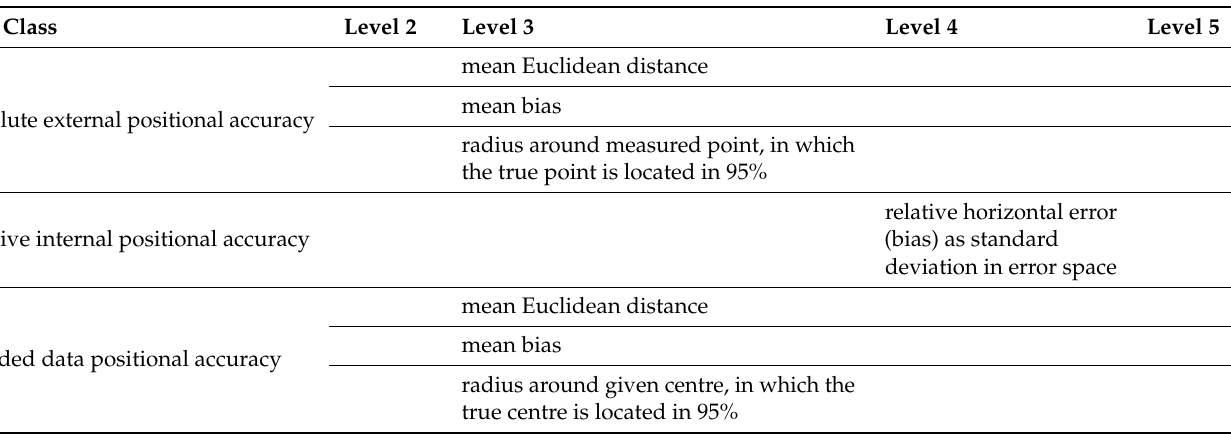
Table A4. Spatial data quality matrix for class positional accuracy.